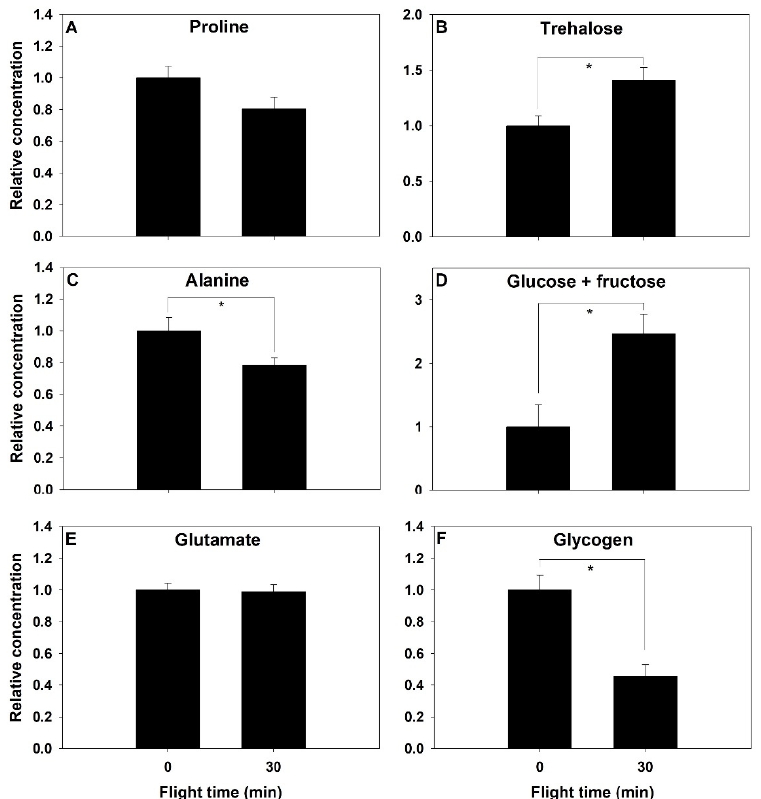
Figure 4. Relative change in energy metabolism intermediates ( A – F ) before and after a 30-min flight in the abdomen of the bumblebee Bombus impatiens . Asterisk indicates a significant difference ( p < 0.05).